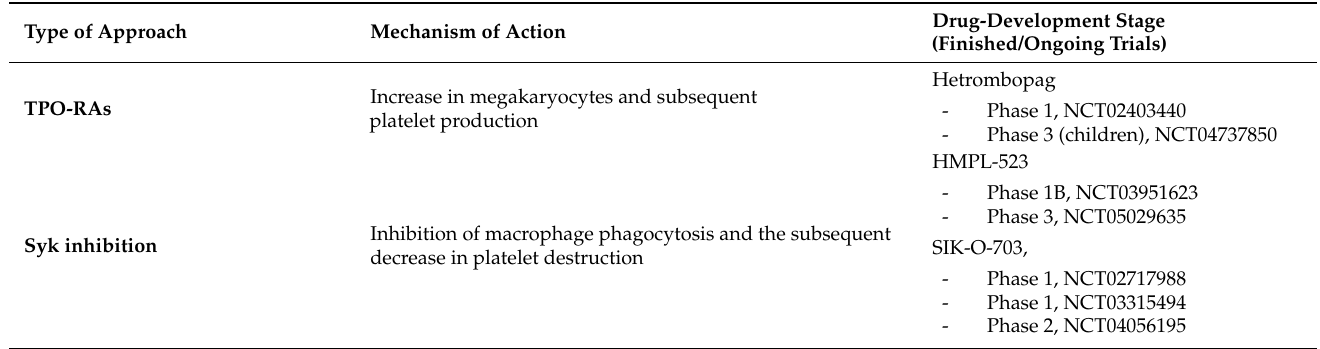
Table 5. ITP treatments that are under clinical